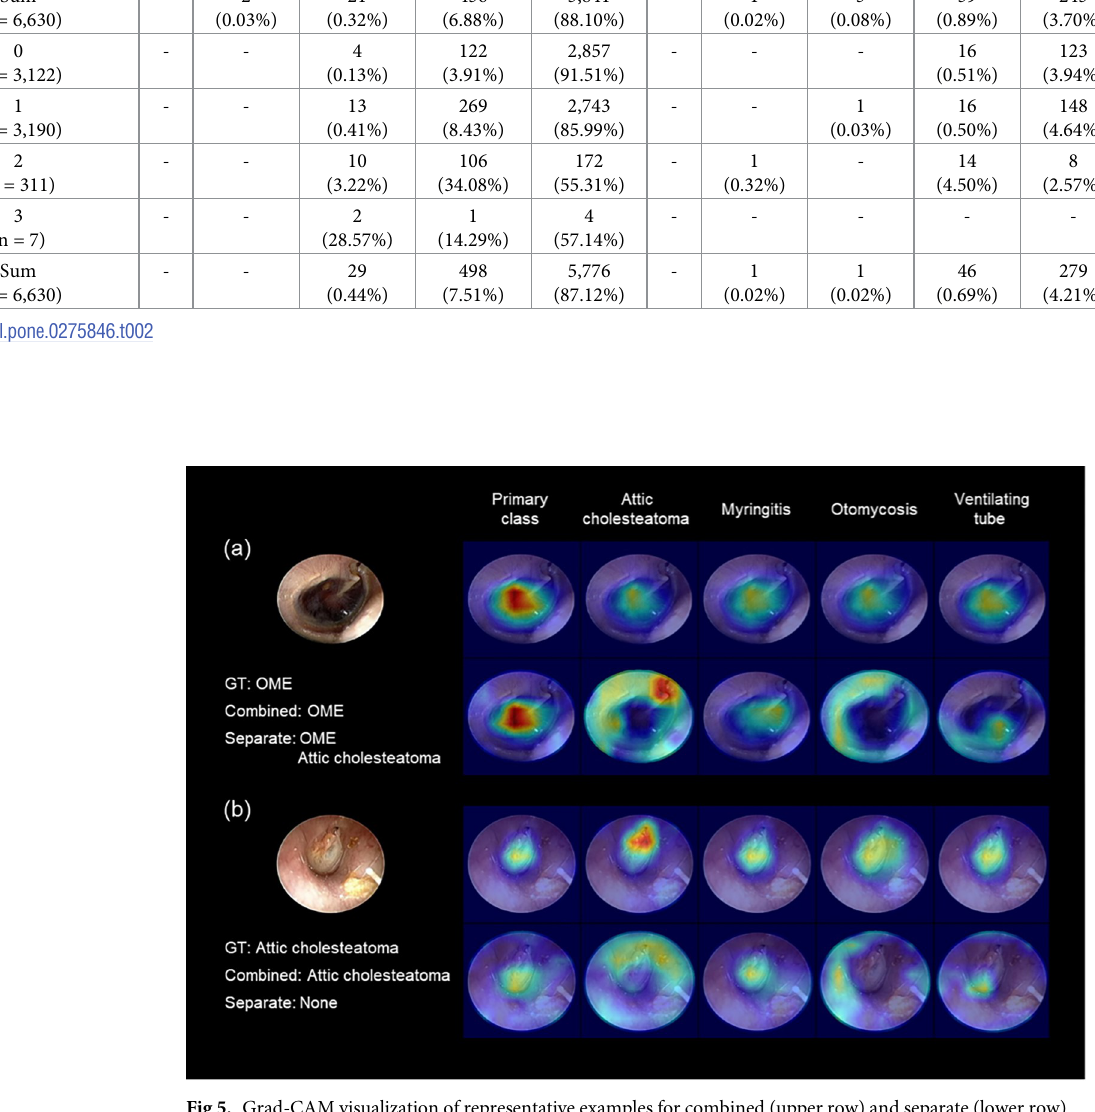
Fig 5. Grad-CAM visualization of representative examples for combined (upper row) and separate (lower row) models. The red area refers to the part of the model where the attention is strong. GT, ground truth; OME, otitis media with